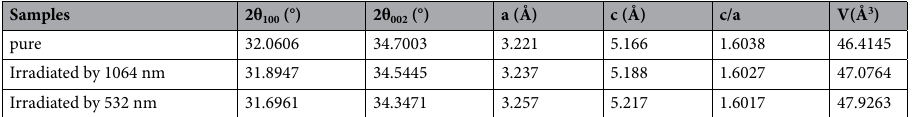
Table 2. ZnO samples Lattice parameters (c, a) before and after irradiated with lasers having wavelengths of 532 nm and 1064 nm .